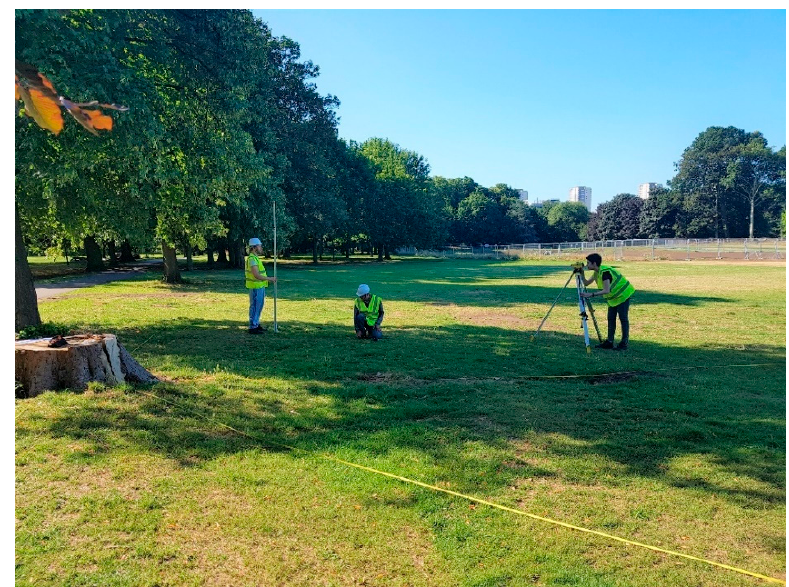
Figure 4. Verification of the accuracy of the excavation area’s coordinates. Note that the tree was felled before the excavation stage (the trunk base is visible on the left-hand side of the picture).